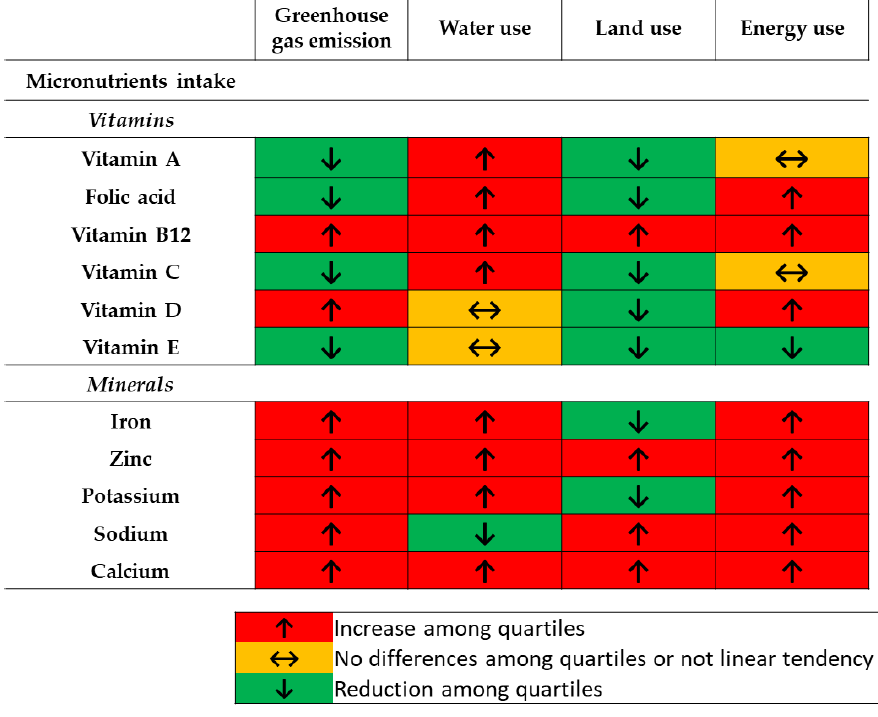
Figure 3. Tendencies in micronutrients intake among energy-adjusted quartiles of the indicated environmental impact indicators.